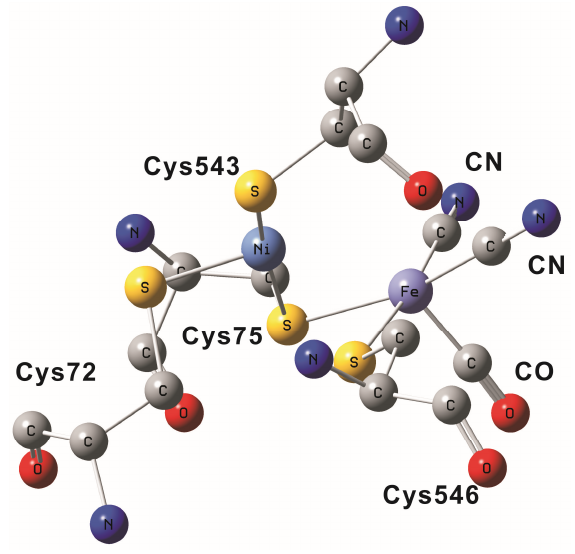
Figure 1. The X-ray structure of the active site of NiFe hydrogenase (Protein Data Bank (PDB) code: 1YRQ) [30].